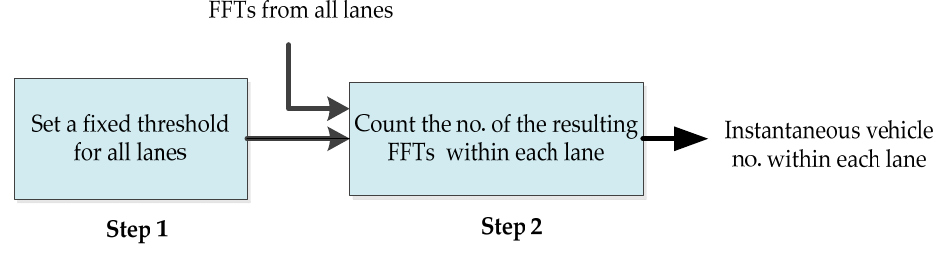
Figure 4. The functional procedure of the conventional approach.